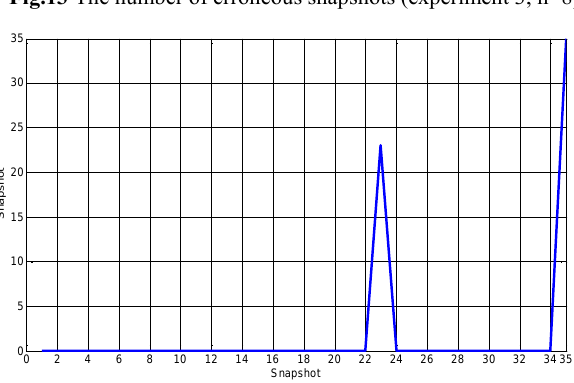
Fig.13 The number of erroneous snapshots (experiment 3, n=8)